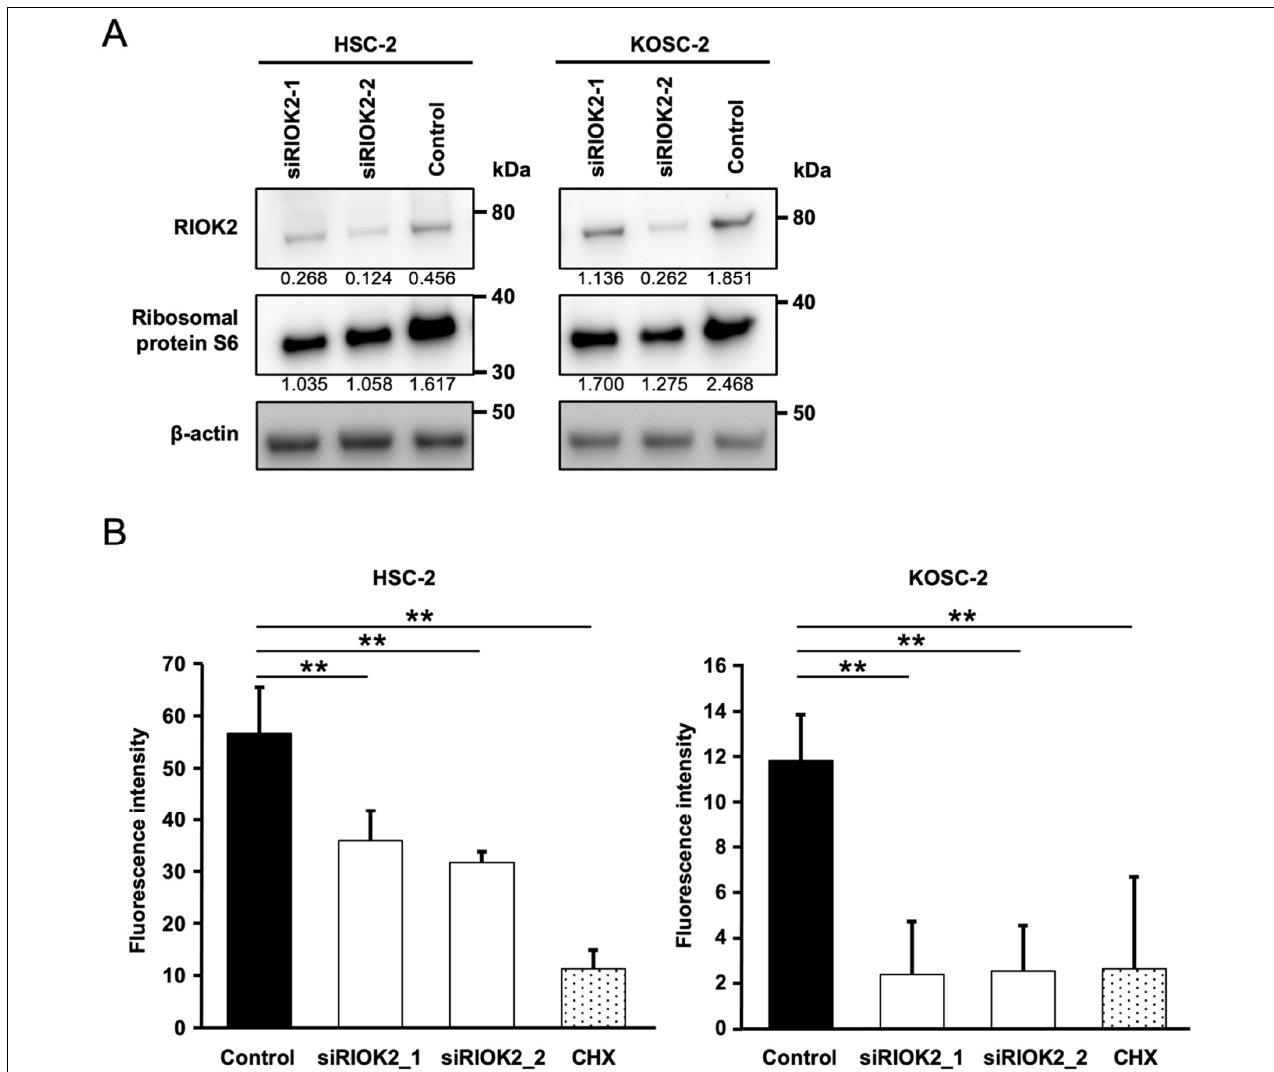
Figure 3. RIOK2 expression affects protein synthesis of the OSCC cell line. ( A ) Western blot analysis of RIOK2 and S6 ribosomal protein in OSCC cell lines transfected with RIOK2 siRNAs. Cell lysates were prepared 6 days after transfection. In this analysis, 5 µg samples of total protein were used. The densitometry intensity/reading ratio (RIOK2/ β -actin and S6/ β -actin) is indicated below the band image. ( B ) O-Propargyl-puromycin labeling of HSC-2 and KOSC-2 cells transfected after 6 days. Fluorescence intensity of 5 FAM-azide was normalized by CellTiter-Glo assay data. Welch’s t -test was used to assess statistical significance (** p < 0.01). The translation inhibitor cycloheximide (1 µg/mL) was used as a positive control. Technical replicates, n = 8.